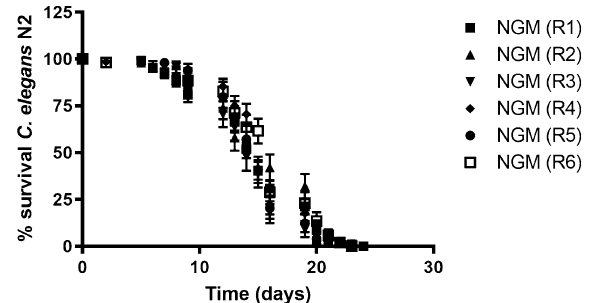
Figure 4. N2 survival curves. The graph was obtained with GraphPad Prism v. 4. Lifespan curves of C. elegans N2 obtained from independent experiments with the automated system, in standard conditions (NGM). Curve comparison was estimated by Log RanK T-test ( p value: 0.699). A comparison among replicates is indicated in Table 2.